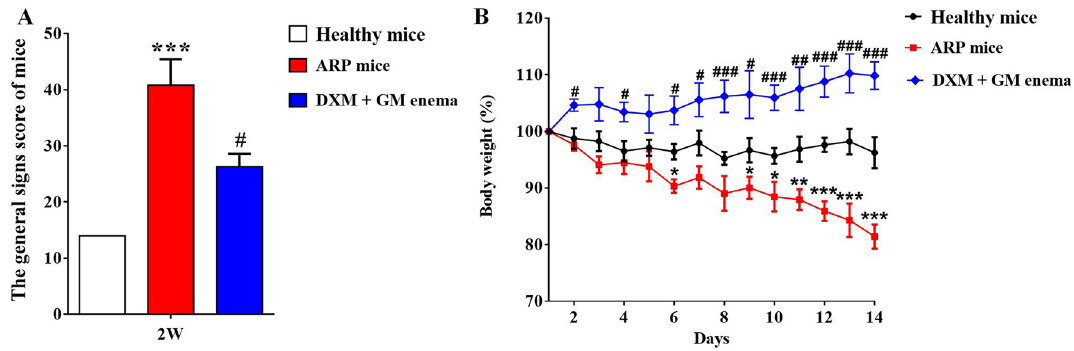
Figure 1. DXM + GM enema ameliorates symptoms and decreases general signs of ARP mice. ( A ) The difference in the general signs score of healthy mice and ARP mice at 2 weeks was significant (*** P < 0.001). DXM + GM enema decreased the general signs score of ARP mice at 2 weeks ( # P < 0.05). ( B ) The body weight of ARP mice was decreased compared with that of healthy mice at 6 days and 9–14 days (* P < 0.05, ** P < 0.01, *** P < 0.001). Conversely, DXM + GM enema increased body weight of ARP mice at 2, 4 days and 6–14 days ( # P < 0.05, ## P < 0.01, ### P < 0.001). Pathological grade Healthy mice